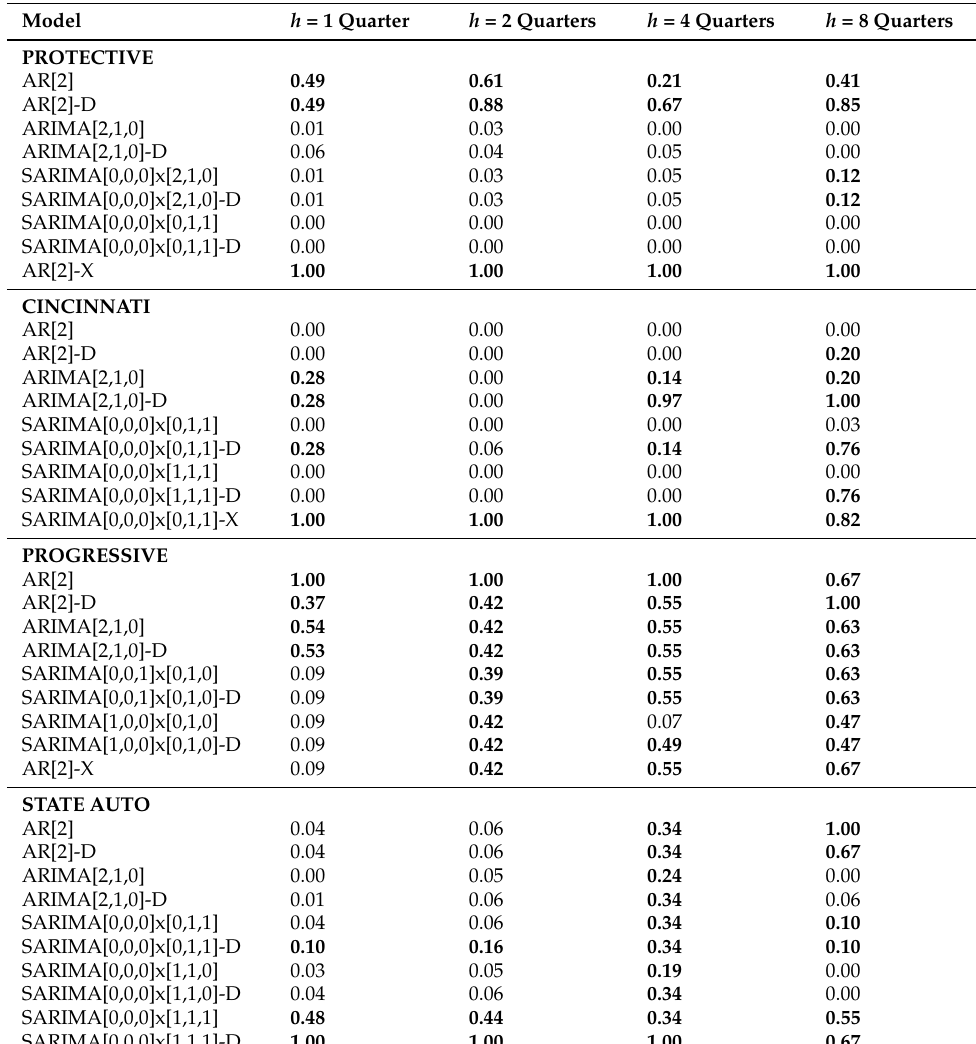
Table 6. MCS p -values with respect to the MAE values of forecasts of underwriting ratios based on 1000 stationary bootstrap resamples for the companies, Protective, Cincinnati, Progressive, and State Auto, and for each of the forecasting horizons h = 1,2,4 and 8 quarters. Forecasts in the 90% MCS in bold